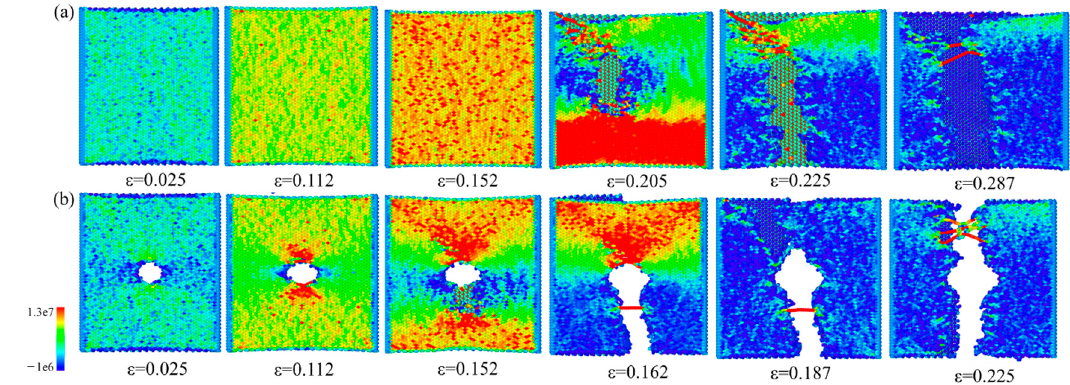
Figure 9. Snapshots of the G/M heterostructure morphology at different tensile strains during uni- axial stretching process. ( a ) Pristine heterostructure. ( b ) Heterostructure nanopore generated with an irradiation parameter pair of 200 eV, 1.27 × 10 16 /cm 2 . The structures are colored according to the per-atom stress information along the horizontal direction, and the value has a unit of stress/(per-atom volume).